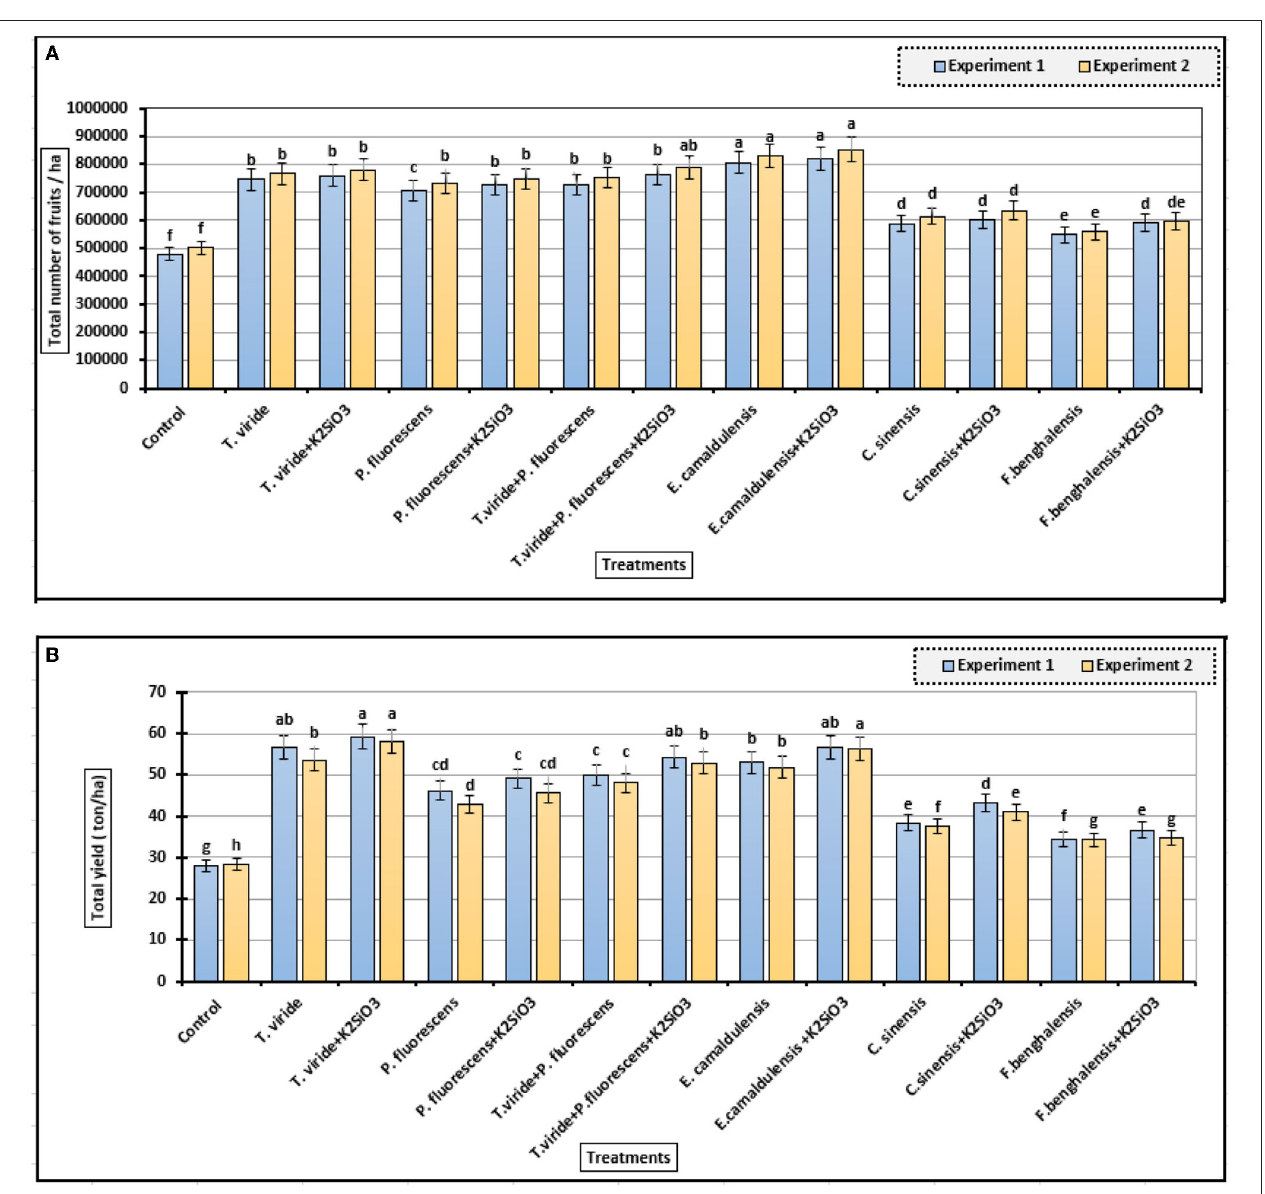
FIGURE 2 | Fruits number and total yield of zucchini as affected by biostimulant treatments. (A) Total number of fruits/ha and (B) The total yield (ton/ha) (means ± S.E) of zucchini as affected by the extracts, microbial inoculations, and K 2 SiO 3 . Letters in the figure indicated that the means ± S.E of treatments with the same letter/s were not significantly different according to Tukey’s HSD level of